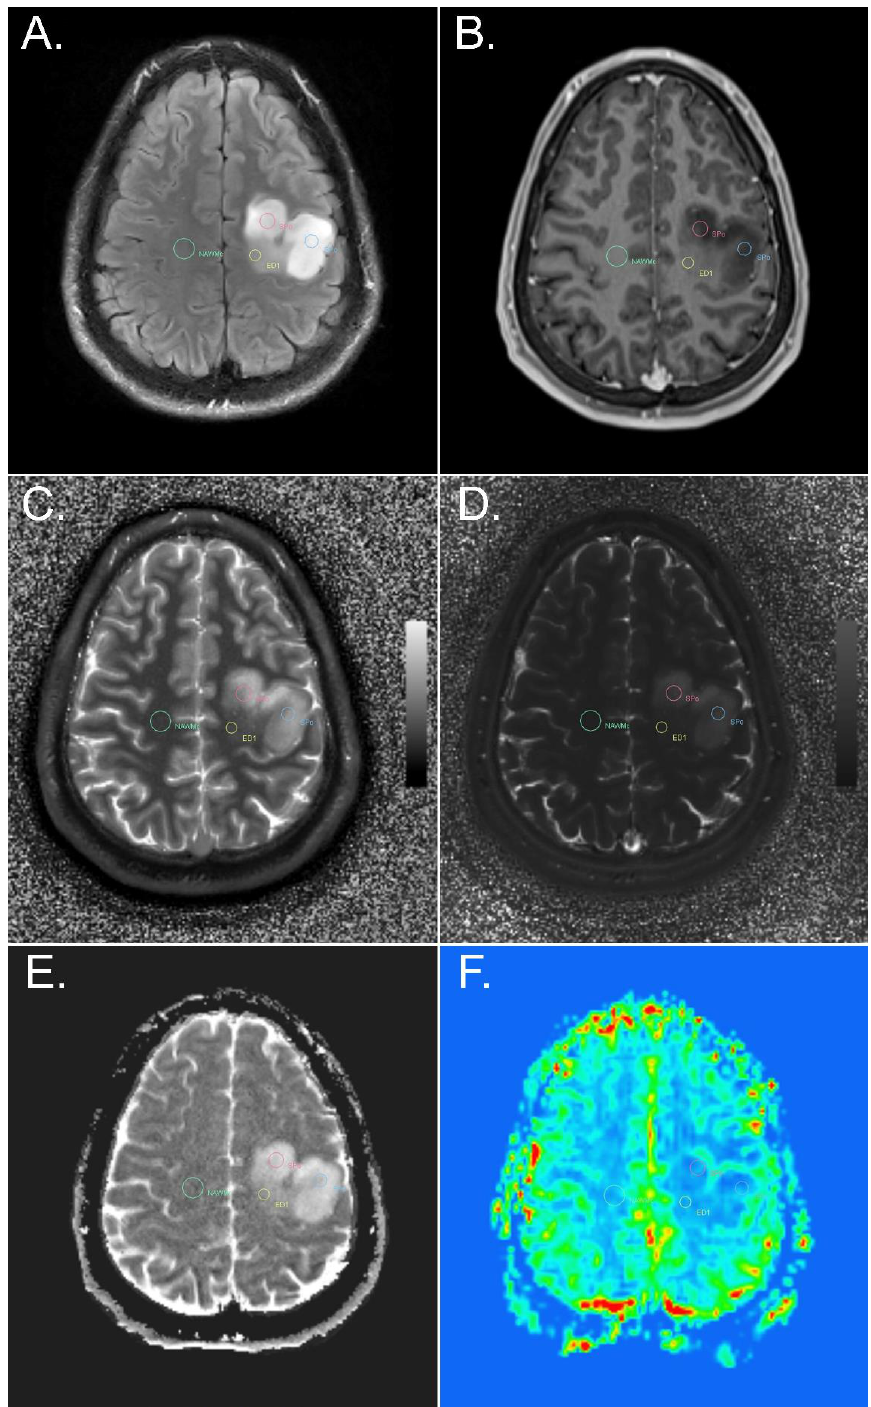
Figure 1. Example of ROI placement in different tumor and peritumoral components of a diffuse astrocytoma, IDH-mutant, in a left precentral location. FLAIR ( A ), T1-weighted MPR post i.v. contrast administration ( B ), MRF T1 ( C ) and T2 ( D ) maps, ADC map ( E ), and perfusion-weighted imaging ( F ). ROIs were placed in the solid tumor part without contrast enhancement and without an increase in rCBV (red and blue circle), in peritumoral edema (yellow circle), and in contralateral NAWM (green circle). SPo, solid part of the tumor without contrast enhancement; ED1, peritumoral edema less than or equal to 1 cm distant from the tumor; NAWMc, contralateral NAWM of the frontal